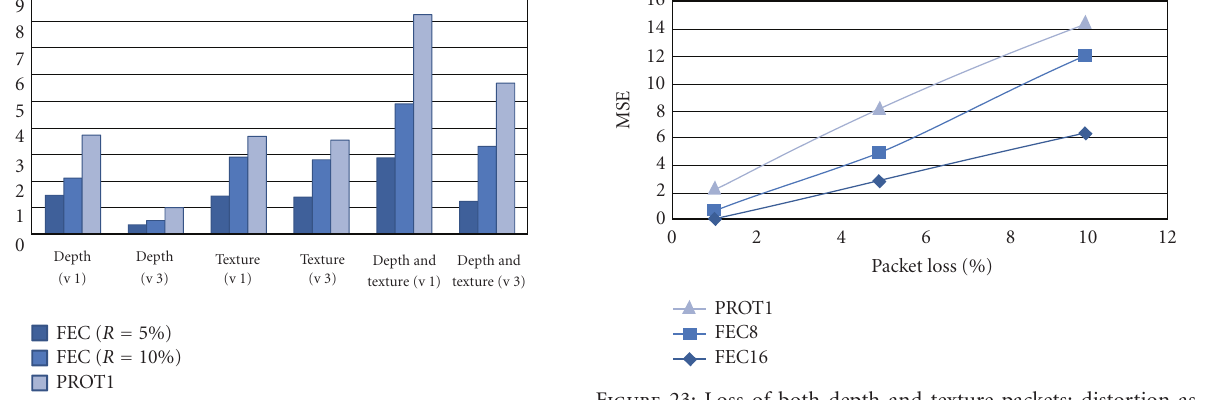
Figure 22: Performance at 5% packet loss rate: distortion due to depth (columns 1 and 2), texture (columns 3 and 4), and joint depth and texture (columns 5 and 6) packet losses with di ff erent error protection schemes.